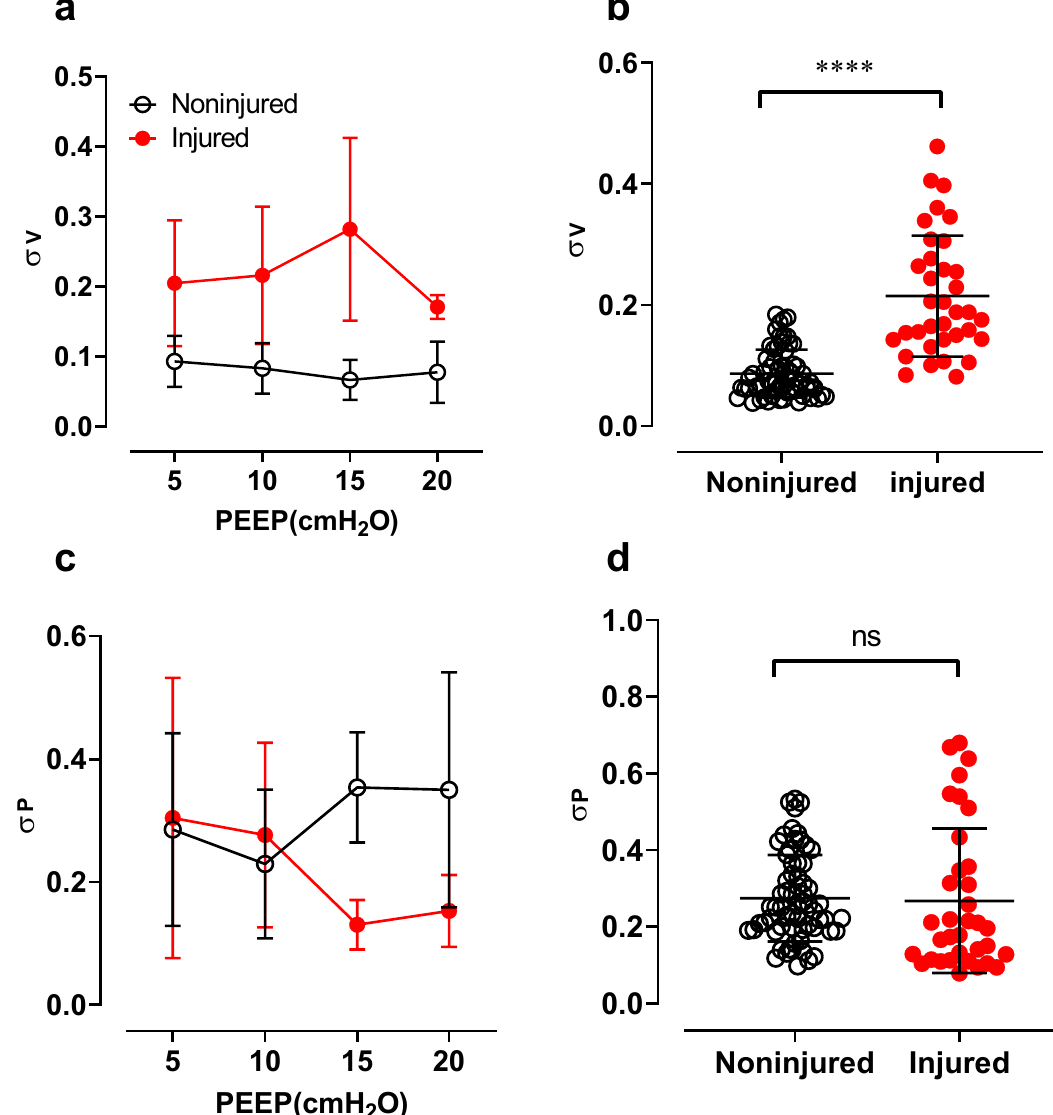
Figure 2. The IST heterogeneity indices in animal data. Panels ( a ) and ( b ) show the distribution of the IST ventilation heterogeneity index (σ V ) in noninjured and injured lungs. Similarly, panels c and d show the IST perfusion heterogeneity index (σ P ). Panels ( a ) and ( c ) present the mean and standard deviation of the IST heterogeneity indices versus PEEP levels. Panels ( b ) and ( d ) present the unpaired Student’s t test comparisons in all PEEP levels. ns: non-significant and **** p <